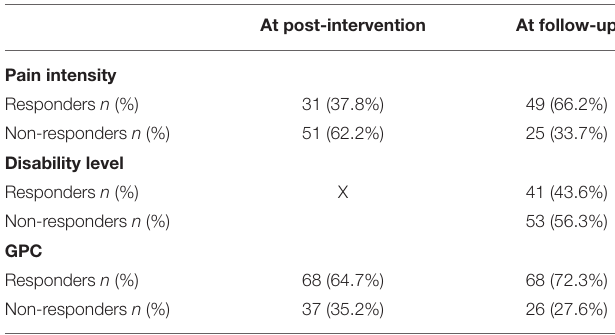
TABLE 4 | Improvement status.